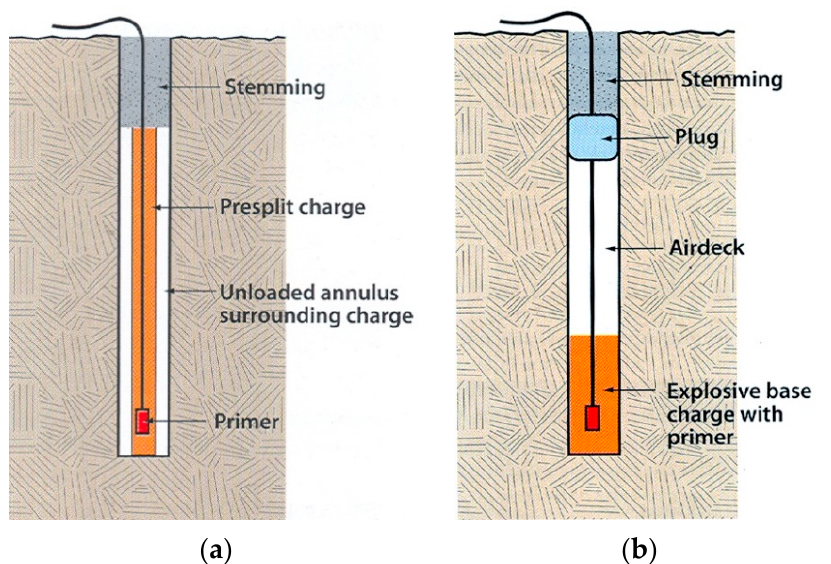
Figure 10. ( a ) Typical presplit column load: the decoupling of the charge with respect to the hole diameter is very clearly observed; ( b ) general air-decked borehole: the bottom charge is triggered by a primer, but most of the hole is unloaded and, in contact with the stemming, at the hole mouth, a plug is inserted with the purpose of “trapping” the air cushion and ensuring a lower impact of the detonation. In both cases, the primer is at the bottom of the hole [11].